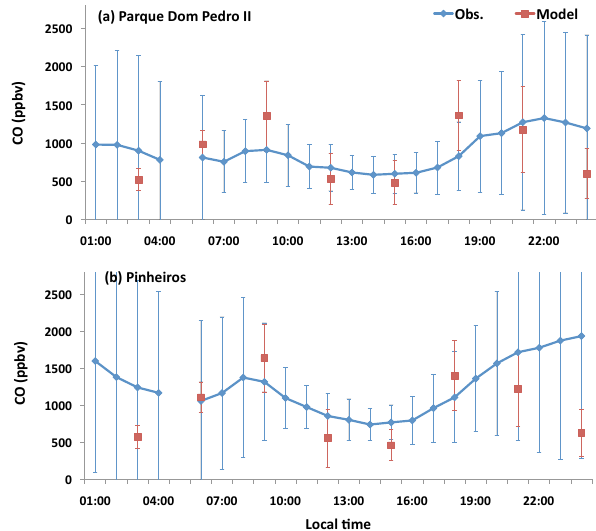
Fig. 11. Monthly average CO mixing ratio (ppbv) from two CETESB ground stations in S˜ao Paulo city, (a) Parque Dom Pe- dro II and (b) Pinheiros, and from the